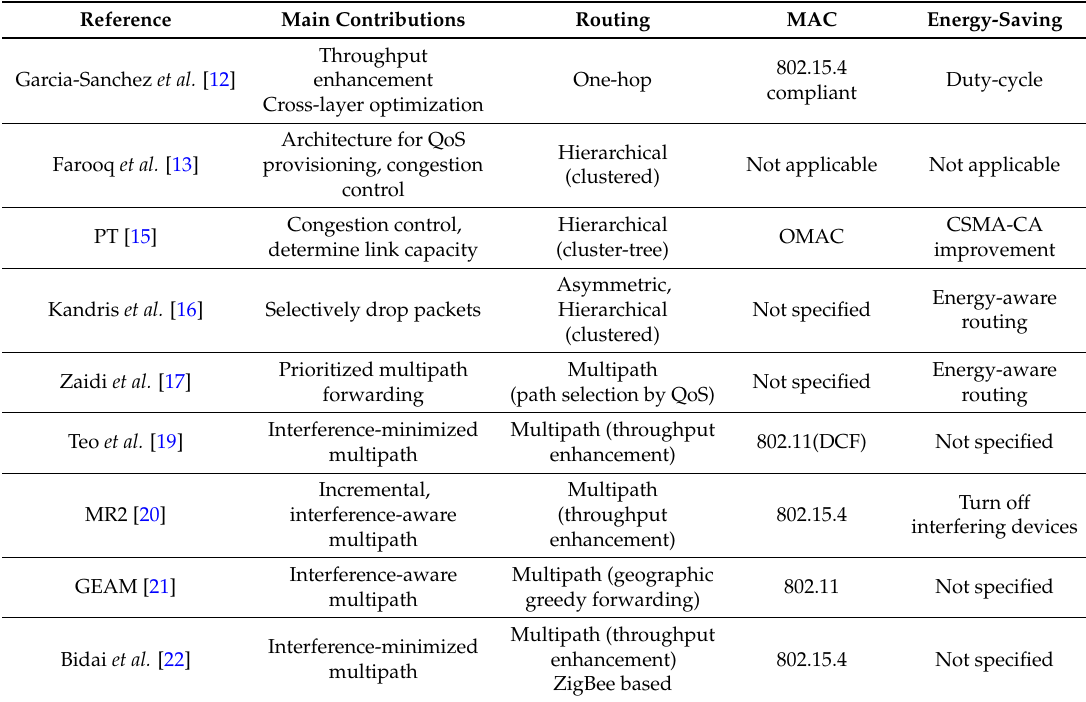
Table 1. Related work